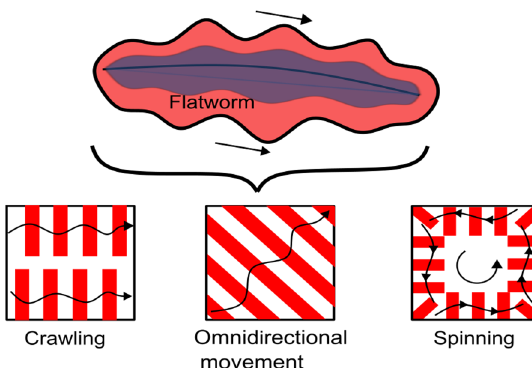
Fig. 1 Concept of multiple travelling wave locomotion inspired by flatworms